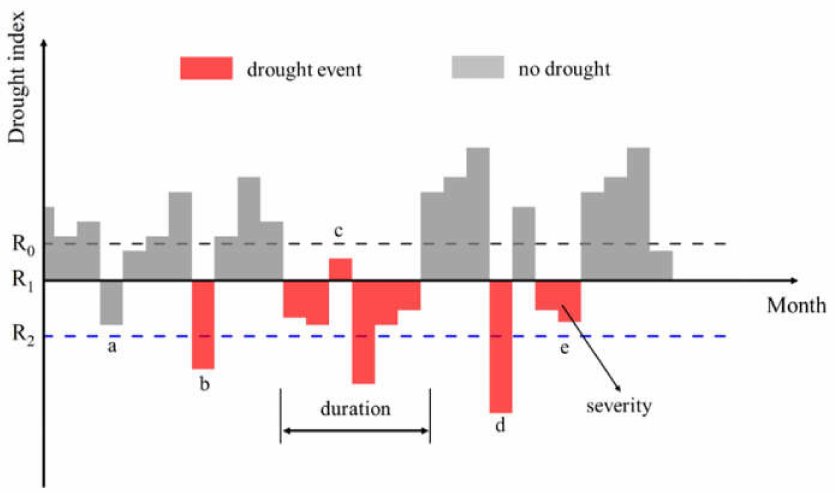
Figure 3. Definitions of hydrological drought and drought characteristic variables (a, b, c, d and e indicate whether a drought event